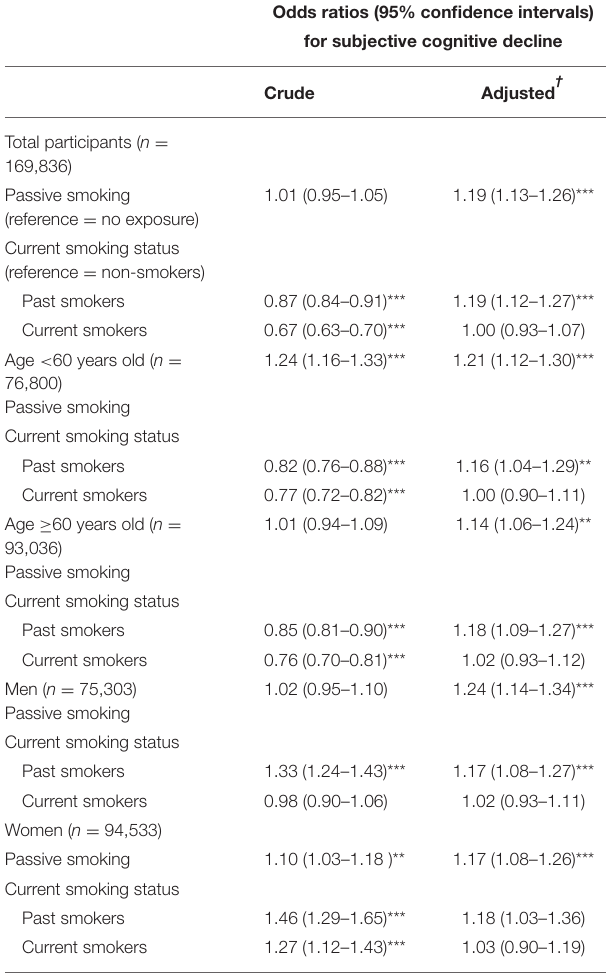
TABLE 2 | Crude and adjusted odds ratios and 95% confidence intervals of passive smoking and current smoking status for subjective cognitive decline. Odds ratios (95% confidence